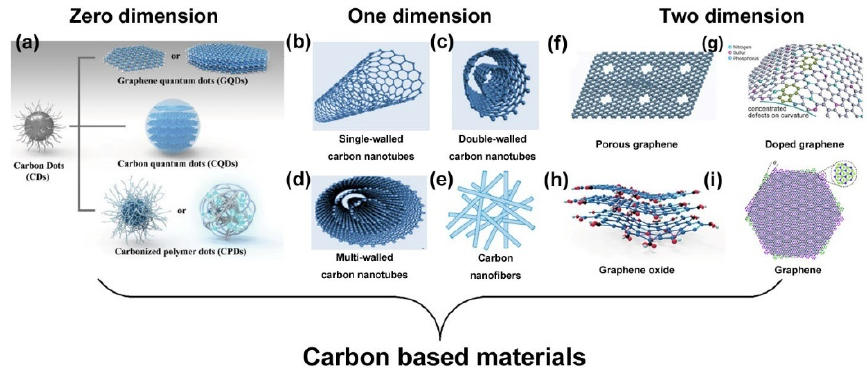
Figure 2. Classification of carbon-based sensors according to the dimension of materials. ( a )